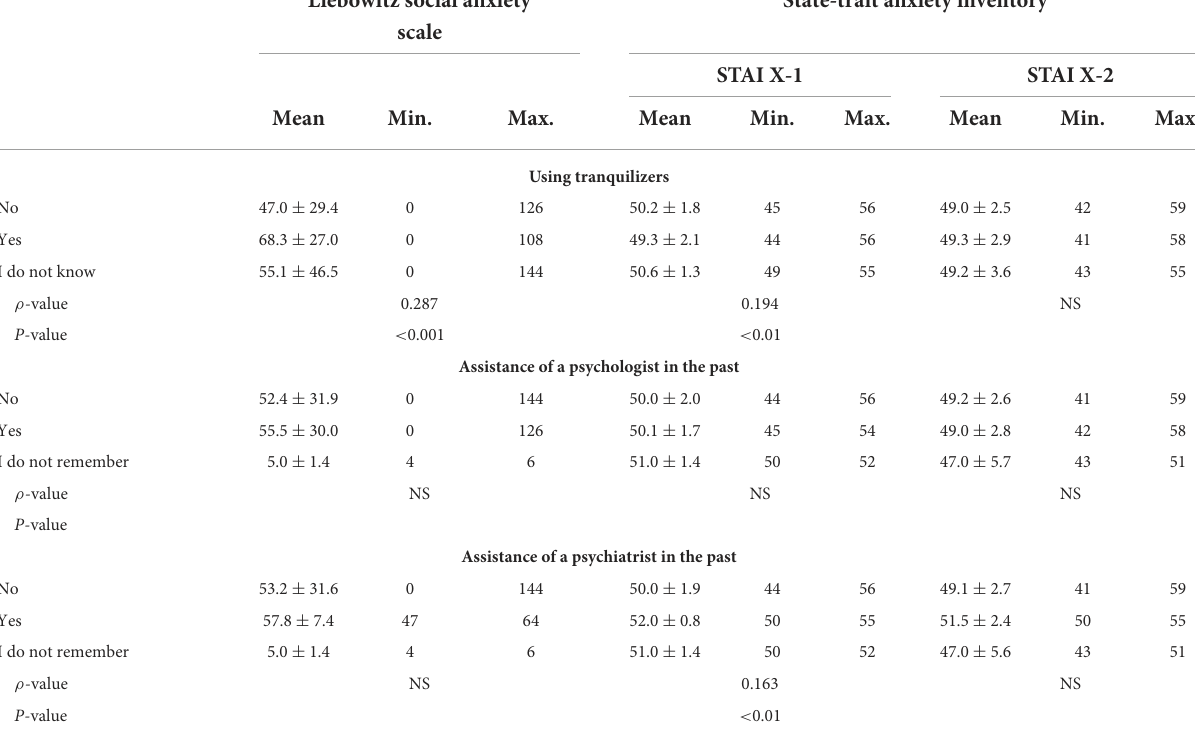
TABLE 6 Level of social anxiety, state anxiety (X-1) or trait anxiety (X-2) and use of tranquilizers or receiving assistance of a psychologist and/or psychiatrist in the past. Liebowitz social anxiety State-trait anxiety